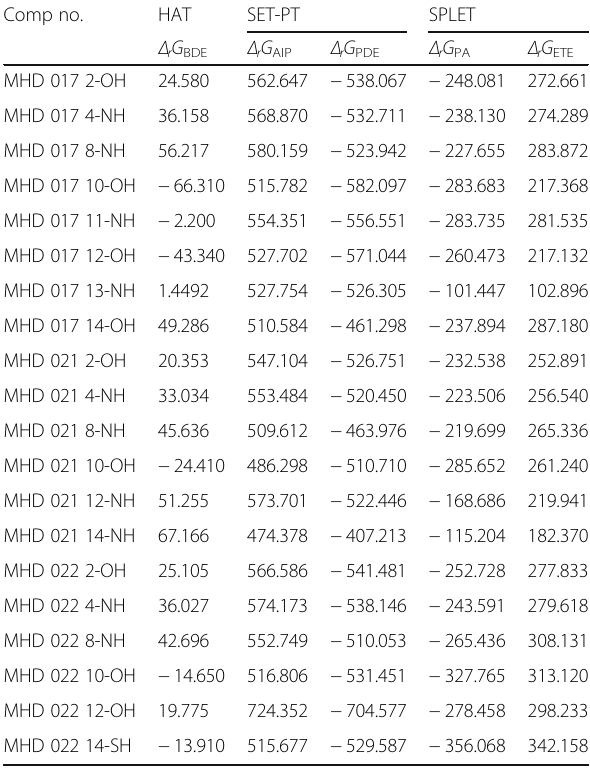
Table 3 The reaction Gibbs free energy ( Δ r G in kJ/mol) of scavenging HOO· radical by hydrazone antioxidants at the B3LYP/6-311G* level in a vacuum Comp no.